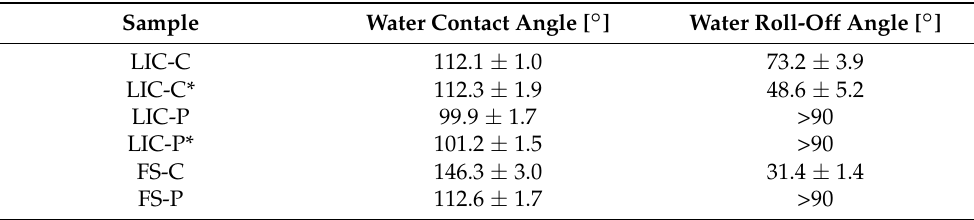
Table 7. Results of the wetting experiments for lubricated icephobic coatings (LICs) and flame- sprayed (FS) additive